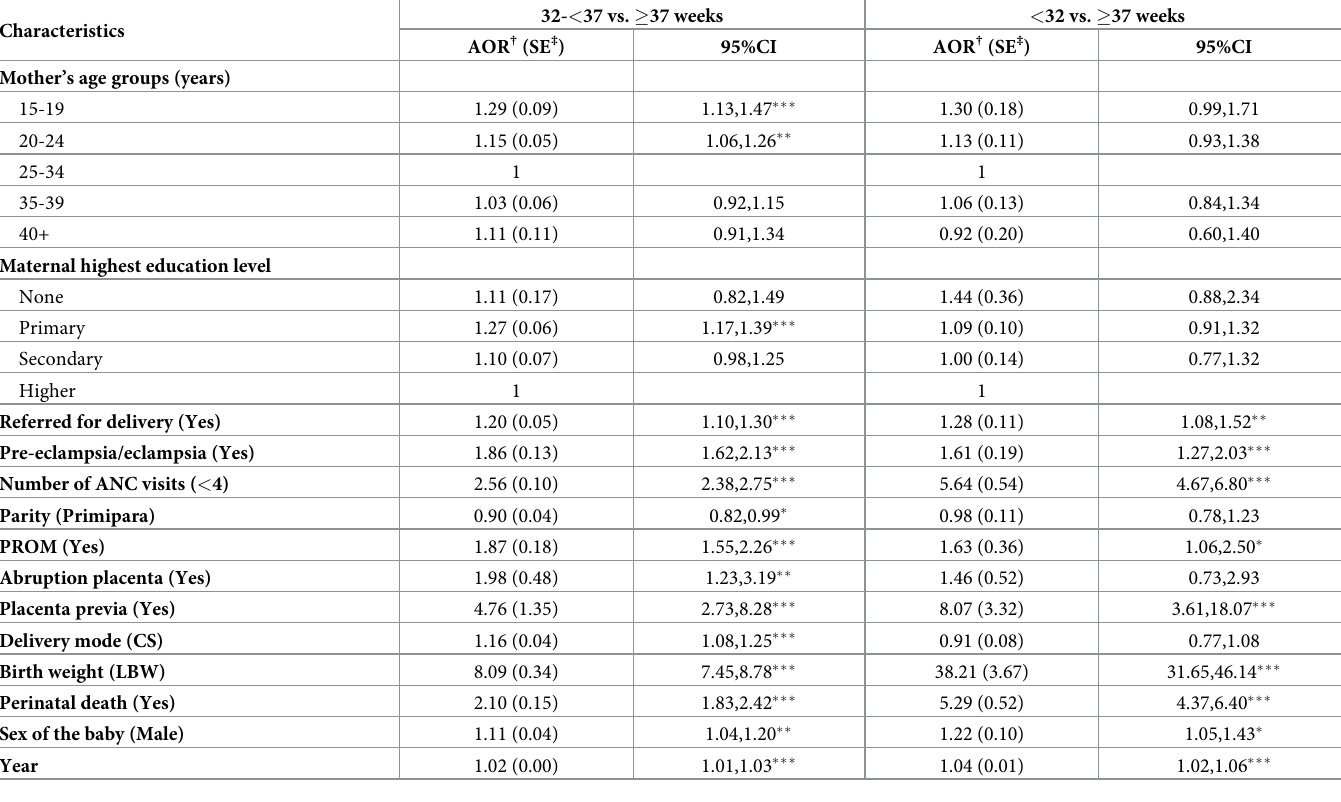
Table 5. Adjusted analysis for predictors of preterm birth using multinomial regression model after imputation of missing values (N = 42,089).